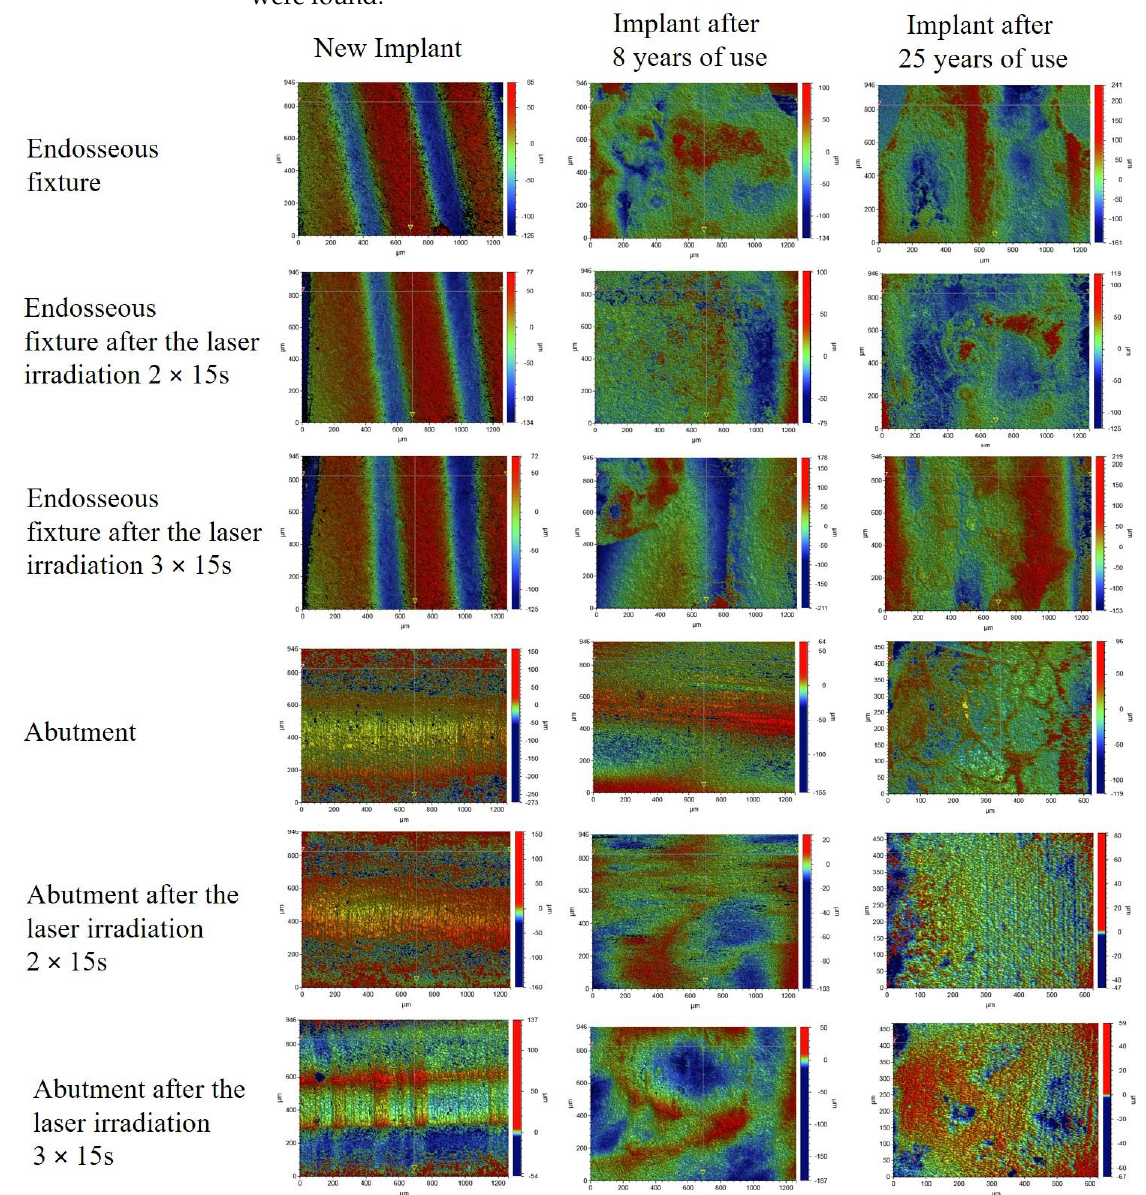
Figure 6. 2D surface microgeometry maps generated by optical profilometry for the implant: new and those, removed after 8 and 25 years before and after the laser irradiation 25 W/15.000 Hz/10 µs, average = 3.84 W in the doses 2 × 15 s and 3 × 15 s.